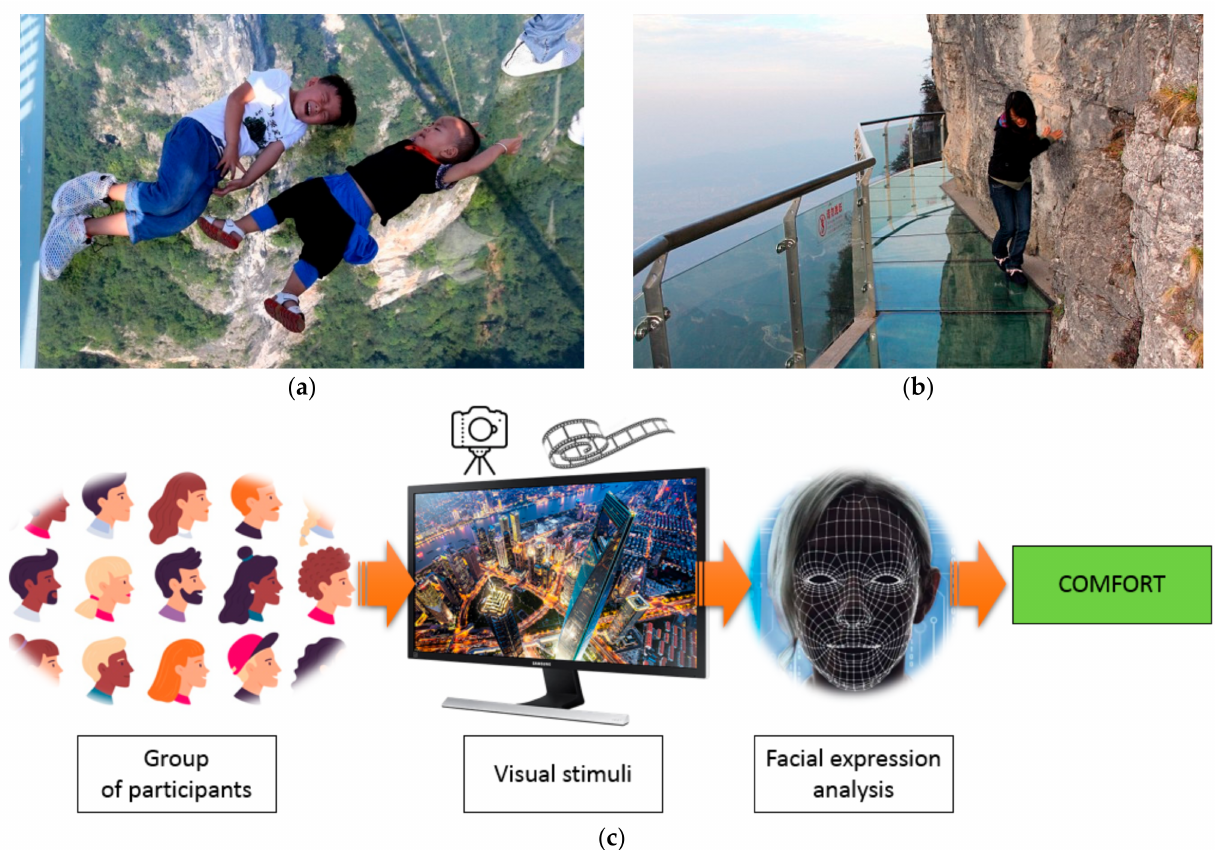
Figure 2. Examples of human reactions on glass structures: ( a ) Zhangjiajie bridge, Hunan, CN (adapted from [26], © Imagechina/REX/Shutterstock); ( b ) Cliffside skyway, CN (adapted from [27], © Visual China Group via Getty Images); and ( c ) a virtual experimental